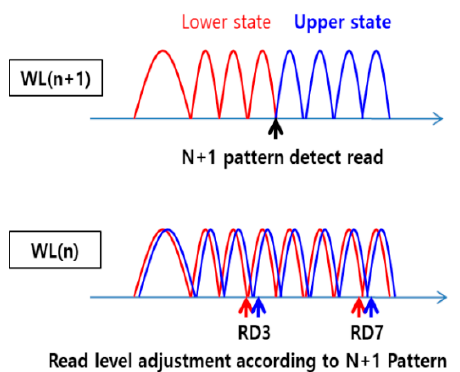
Figure 11. Read level adjustment scheme according to N + 1 WL pattern. Reprinted/adapted with permission from Ref. [58], 2022, IEEE.